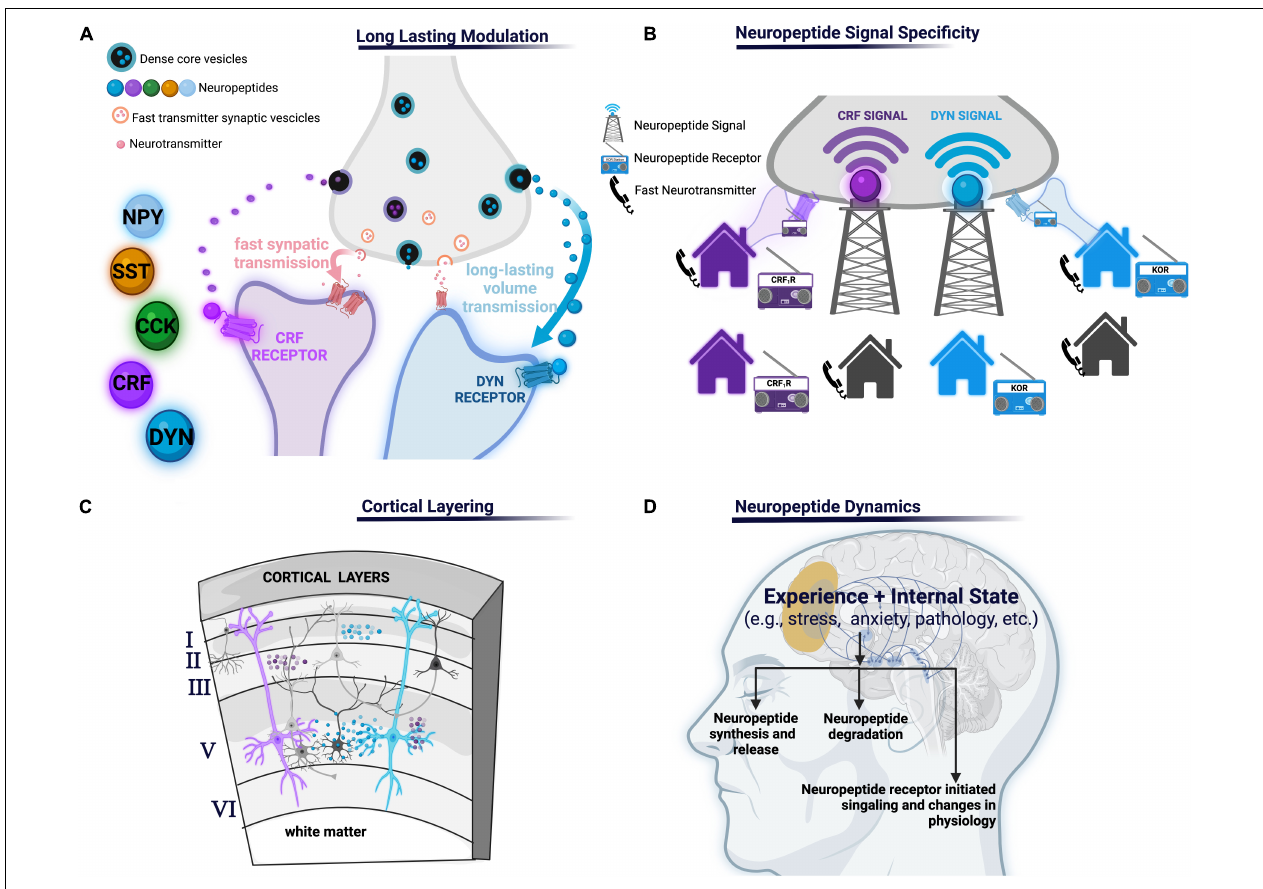
FIGURE 1 | (A) Long-lasting modulation: neuropeptides may mediate communication across longer time scales and larger volumes leading to long-lasting modulation of neural processes relative to shorter volumes and shorter duration of other molecules such as fast amino acid neurotransmitters. (B) Neuropeptide signal specificity: neuropeptide transmitters can only be detected if the appropriate neuropeptide receptor is present (like a radio signal the neuropeptide signal can only be received if the radio is tuned to the corresponding radio station, unlike a phone which receives point-to-point calls). (C) Cortical layering: different cortical layers may have different peptides or receptors and/or concentrations due to various factors including, but not limited to, differential arborization of PFC neuropeptide- and receptor-expressing cells, concentrations of degrading enzymes, or afferent inputs containing presynaptic receptors. (D) Various aspects of neuropeptides transmissions are subject to change, including neuropeptide production and release, degradation by peptidases, or signaling depending on the experience or internal state of an organism. NPY, neuropeptide Y; SST, somatostatin, CCK, cholecystokinin; CRF, corticotropin-releasing factor; KOR, κ -opioid receptor, CRF 1 R, corticotropin-releasing factor type